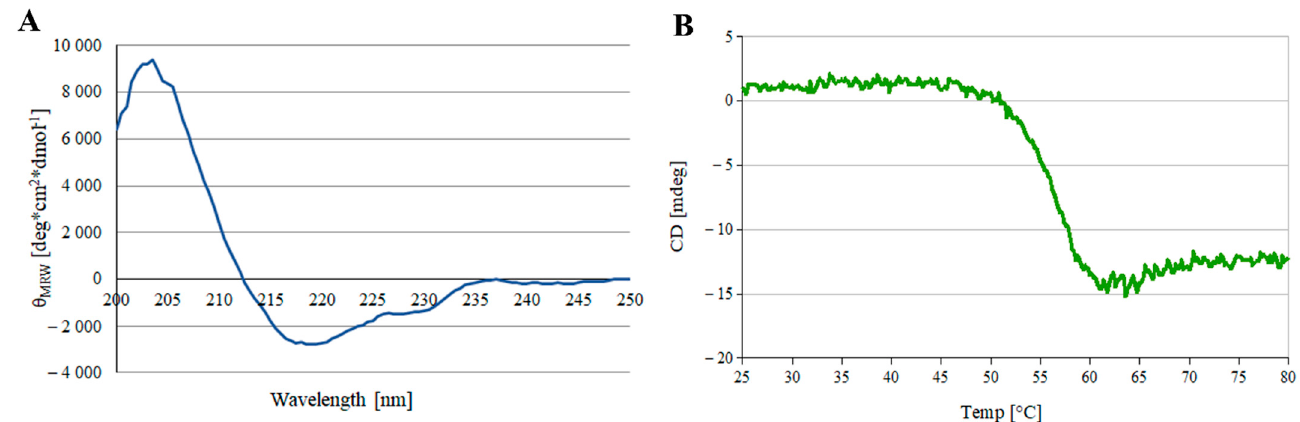
Figure 2. CD analysis of the scFv D2–5-HT1A protein. ( A ) CD spectrum of the protein. The curve is the mean value of three separate scans with the buffer values subtracted. ( B ) Temperature scan at 297 nm used to access the denaturation temperature.